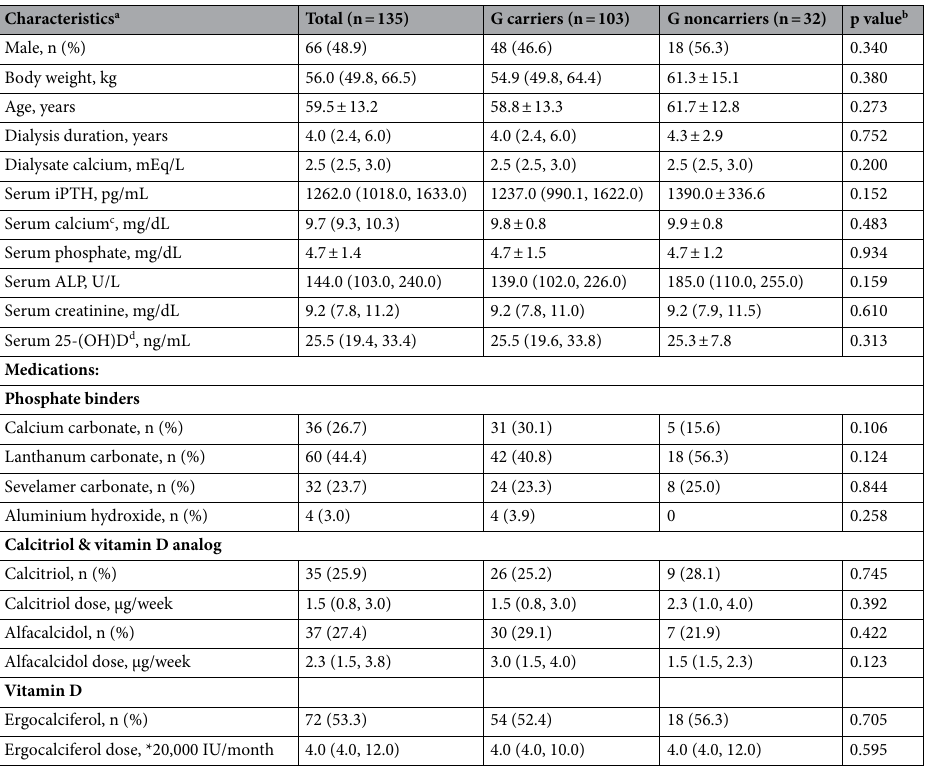
Table 1. Baseline characteristics and medication use on the day of starting cinacalcet treatment. iPTH intact parathyroid hormone, ALP alkaline phosphatase, 25-(OH)D 25-hydroxy vitamin D. a Continuous data are expressed with either means ± standard deviations if they are normally distributed or medians (interquartile ranges) if they are not normally distributed. b The p values were calculated with the use of the chi-square test, the Mann–Whitney U test, or the t-test for comparison between G carriers and noncarriers. c Serum calcium is reported as albumin corrected values if serum albumin was less than 4.0 g/dL [corrected calcium in mg/ dL = measured calcium in mg/dL + 0.8*(4—serum albumin in g/dL)]. d Serum 25-(OH)D was that of 126 patients